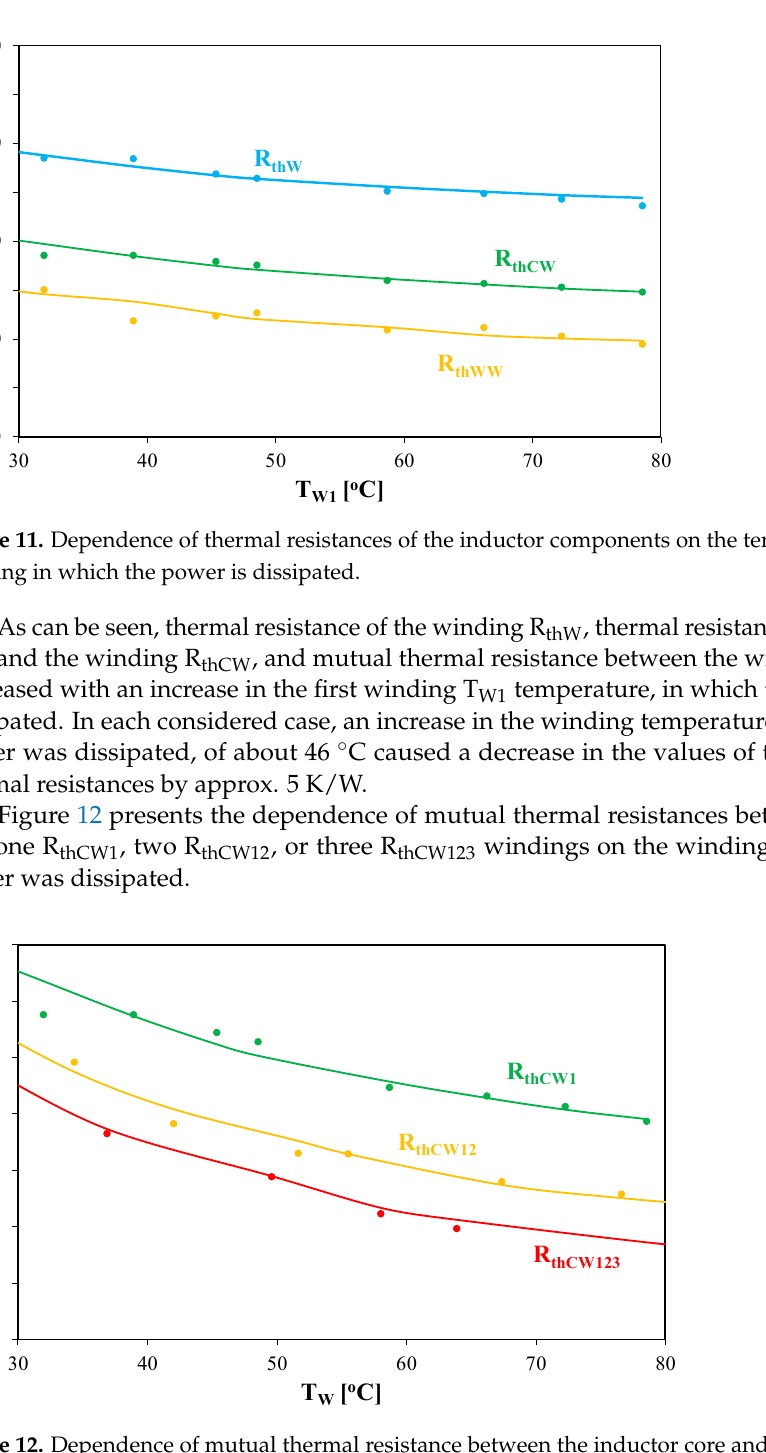
Figure 12. Dependence of mutual thermal resistance between the inductor core and the winding on the winding temperature for one, two, and three series ‐ connected windings.